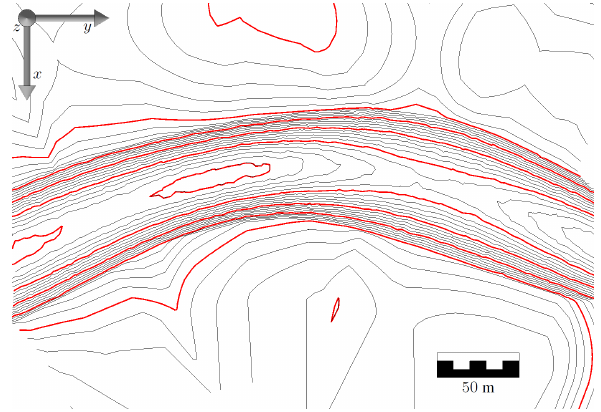
Figure 6: Planimetric position of tie-points. The black line are the UAV flight path. Yellow dots are seen by both N-S and E-W flight lines, blue dots only from N-S or E-W flight lines.